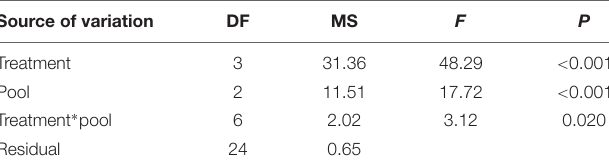
TABLE 1 | ANOVA results for the effects of harvesting treatment (cut 3 cm, cut 1 cm, and pull) and pool (Fanad A, Fanad B, and Killough) on growth rate of Corallina officinalis